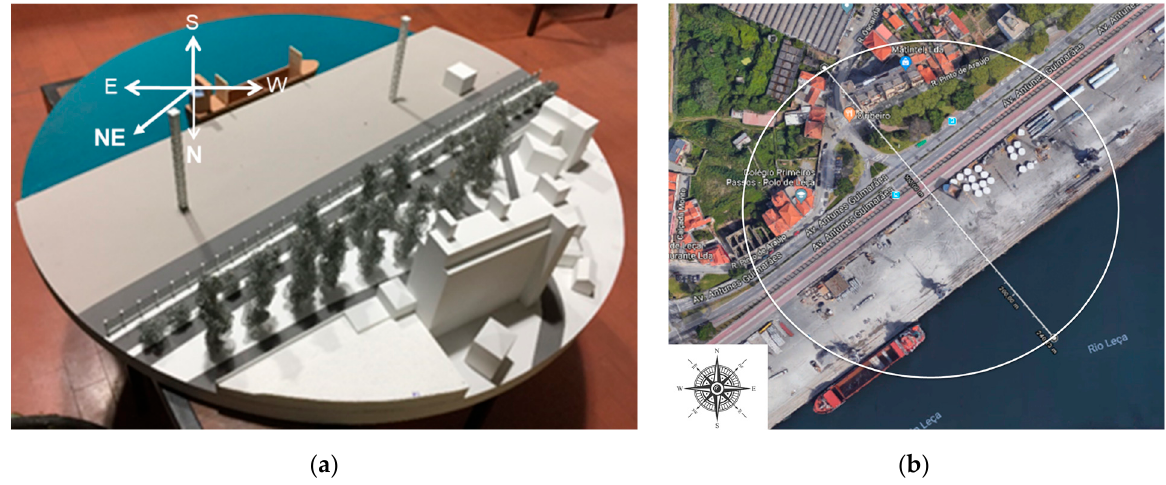
Figure 3. ( a ) Mock-up used in the wind tunnel experiments. The figure also shows a schematic representation of the orientation of mock-up with reference to the wind directions under analysis: North (N) and North-East (NE). ( b ) Geographical area represented in the mock-up.